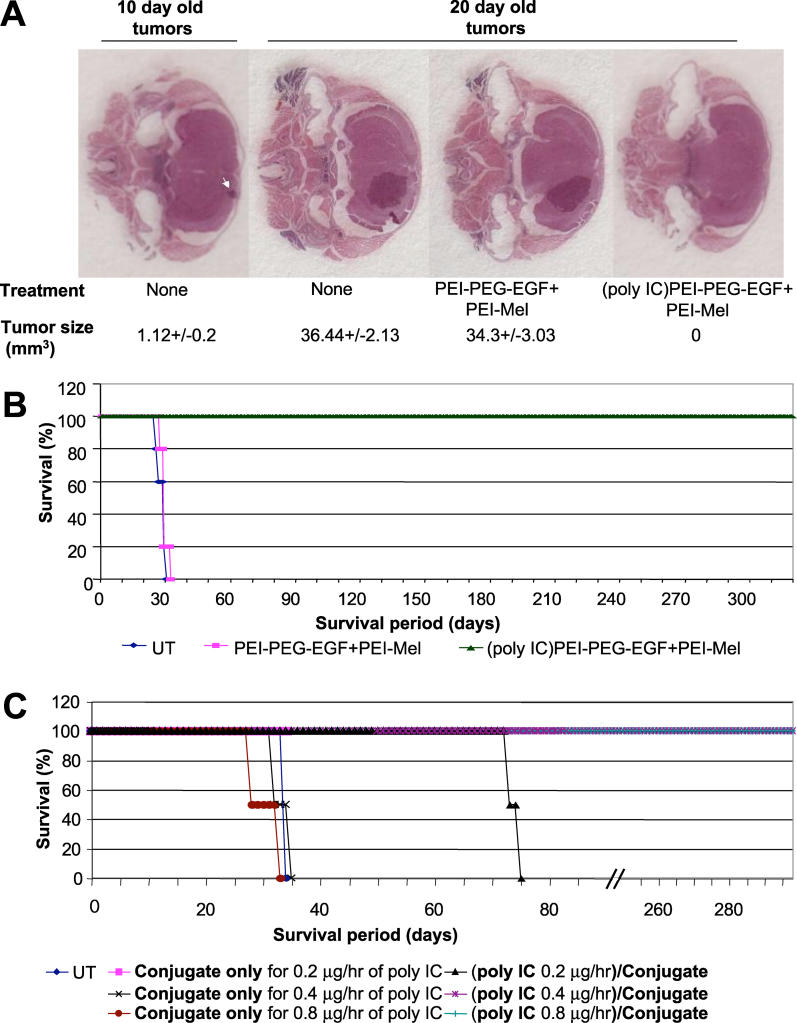
Targeted Poly IC Eliminates Intracranial GBM Models(A and B) (poly IC)PEI-PEG-EGF+PEI-Mel complexes eliminate U87MGwtEGFR xenografts. Intracranial U87MGwtEGFR tumors were established and treated with formulated poly IC as described in Methods. (A) Sizes of the tumors before and after the treatment. (B) Survival of the animals (Methods).(C) In vivo bystander effect. A mixture of 5,000 U87MGwtEGFR and 5,000 U87MGΔEGFR cells was implanted into the brain of nude mice as described in Methods. The mixed tumors were treated with formulated poly IC (poly IC-/conjugate) at the indicated doses, and control animals received equivalent doses of PEI-PEG-EGF+PEI-Mel complexes without poly IC (Conjugate only). Survival of the animals was analyzed as above. Mice receiving 0.2μg/h of poly IC die up to day 75, whereas those receiving 0.4 μg poly IC/h and 0.8 μg poly IC/h are still alive.